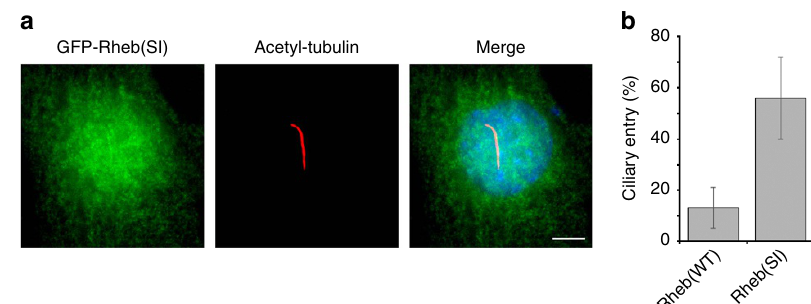
Figure 7 | Ciliary entry of Rheb is dependent on the affinity to PDE6 d . ( a ) Localization of Rheb(SI) mutant (green) in IMCD3 cells which were stably transfected with the GFP-tagged protein. White bar indicates 5 m m. ( b ) Bar chart showing the percentage of Rheb-positive cilia. Data were collected from two independent experiments for each Rheb(WT) (38 and 87 cells per experiment) and Rheb(SI) (92 and 126 cells per experiment). Error bars indicate s.d., n Z 125 ( P o 0.05; Student’s t -test).